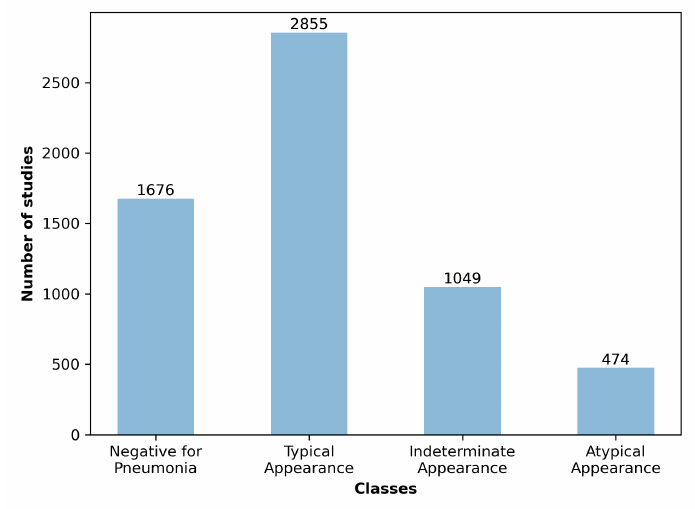
Figure 2. Study-level classes in the data